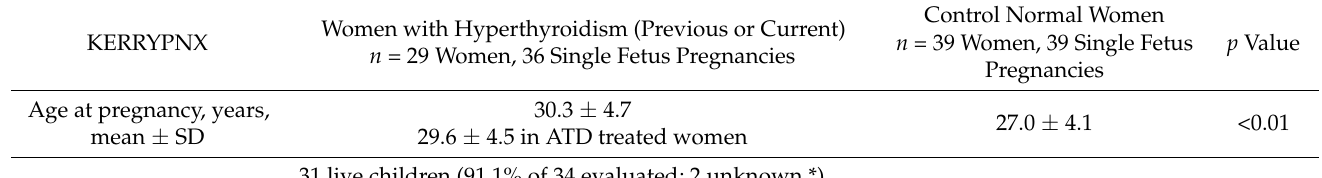
Table 4. Pregnancy